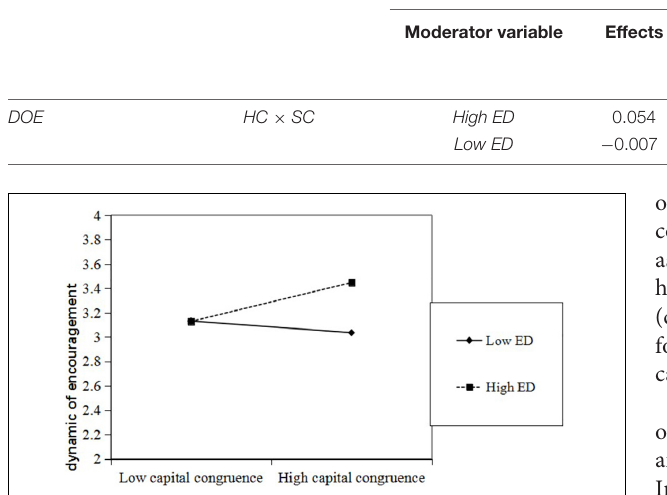
between human capital and social capital. Drawing on